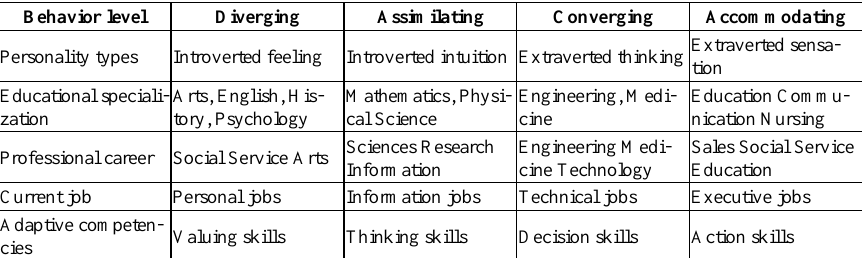
Table 3. Relationship between specialized learning styles and five levels of behaviour